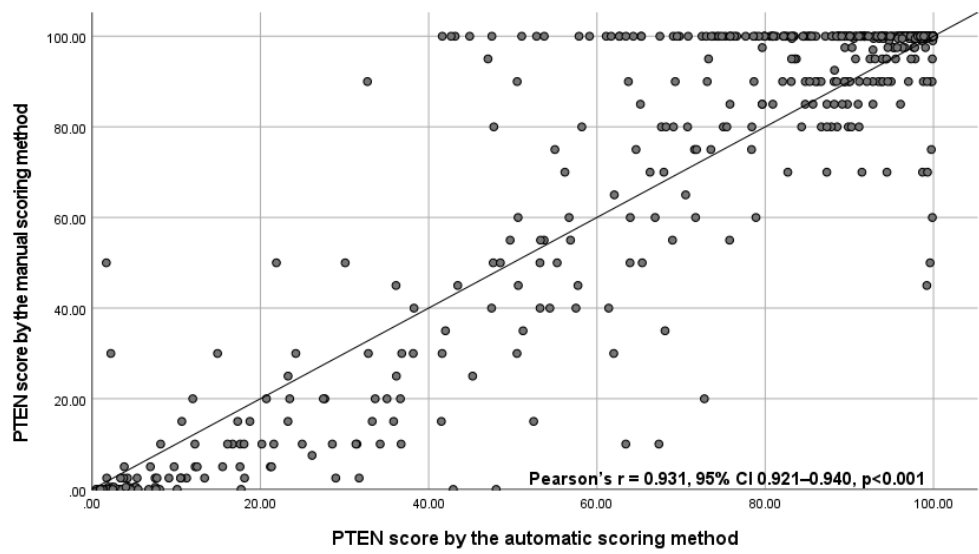
Figure 2. Scatterplot with correlation coefficient between the automatic PTEN score and the manual PTEN scores for 694 whole slide images with valid scores obtained by both scoring methods. Abbreviations: CI = confidence interval, PTEN = phosphatase and tensin homologue, SD = standard deviation.